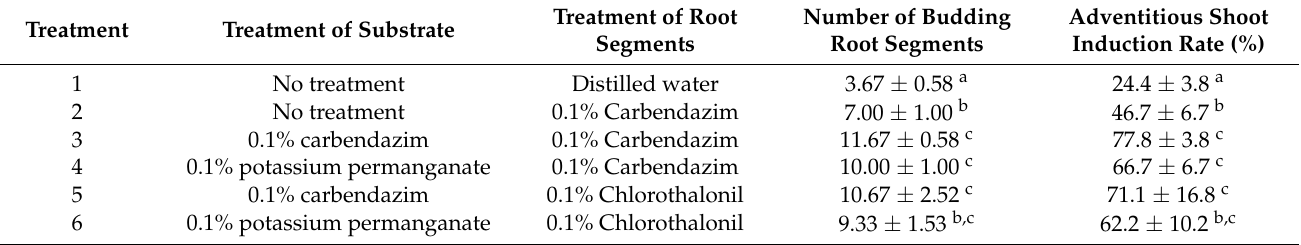
Table 8. Effects of different disinfection combinations on root propagation induction rate.